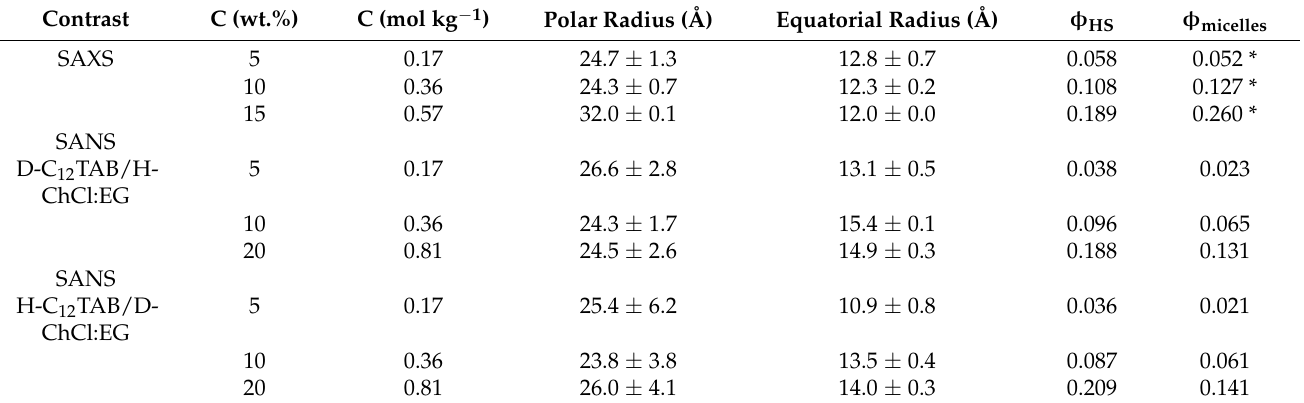
Table 2. SAXS and SANS fitting parameters for binary eutectic